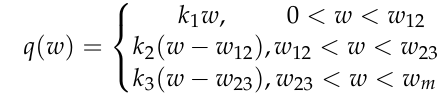
Table 1. Parameters of the bilinear approximation.